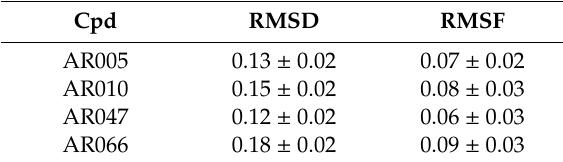
Table 1. Average values of Root-Mean-Square Deviations (RMSD) and Root-Mean-Square Fluctuations (RMSF) of the four studied complexes.